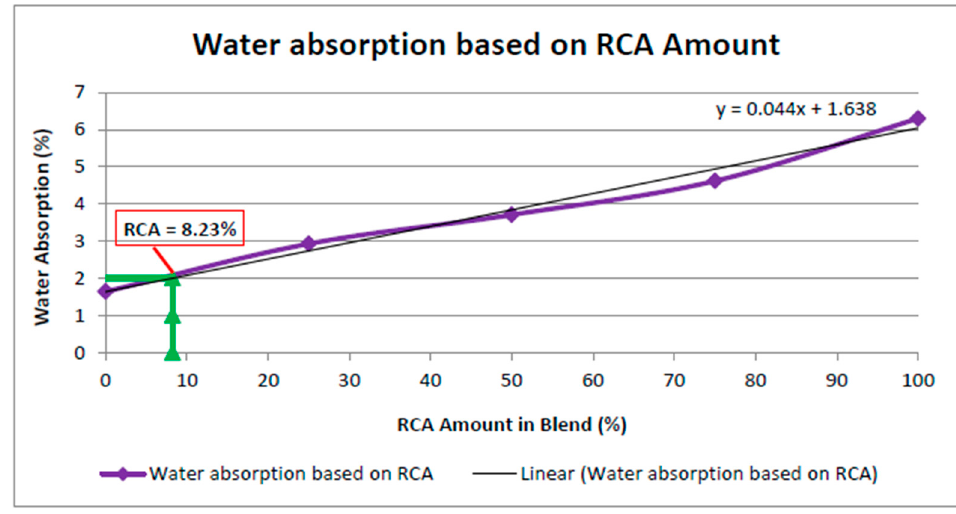
Figure 17. Regression Analysis for Determination of Optimum recycled construction aggregate (RCA) Amount.